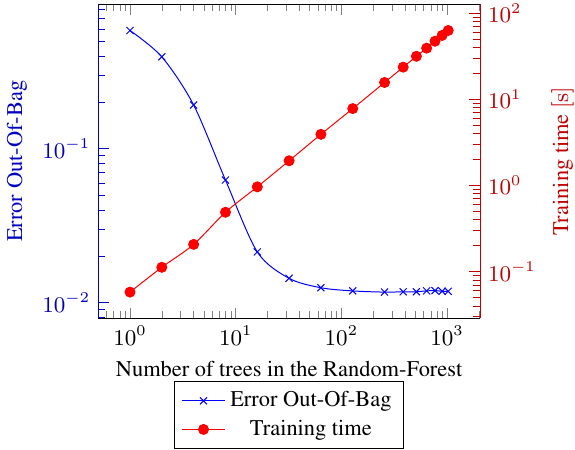
Figure 5: Importance of number of trees in the